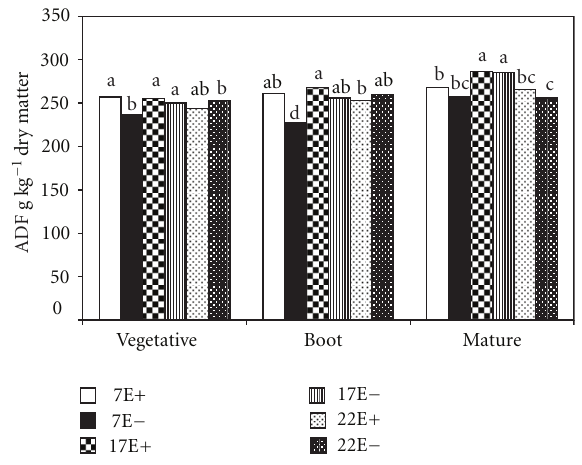
Figure 3: Plant × endophyte × maturity e ff ect on g kg − 1 dry matter ADF concentrations from the greenhouse. Within maturity, bars with di ff ering letters are significantly di ff erent at P = .